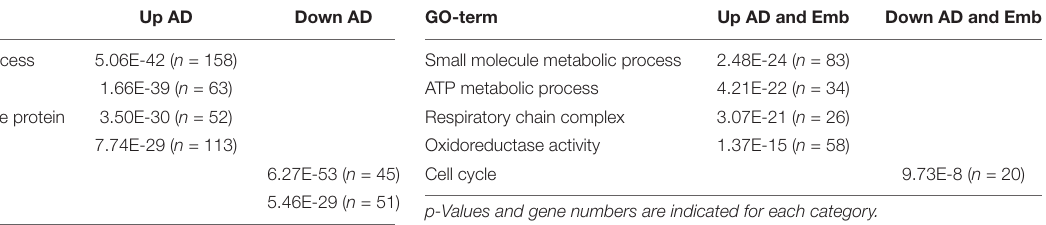
TABLE 1 | Main gene ontology terms enriched in genes over- (up AD) or under- (down AD) expressed in adult as compared to larval hemocytes. GO-term